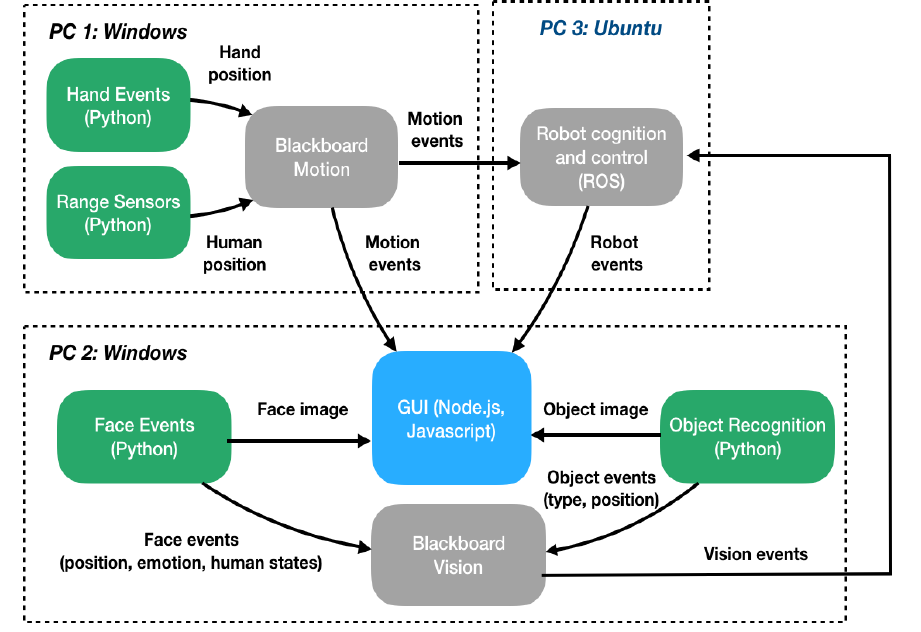
Figure 7. General software architecture of the HRI application performed in the International Robot Exhibition (IREX) 2019.